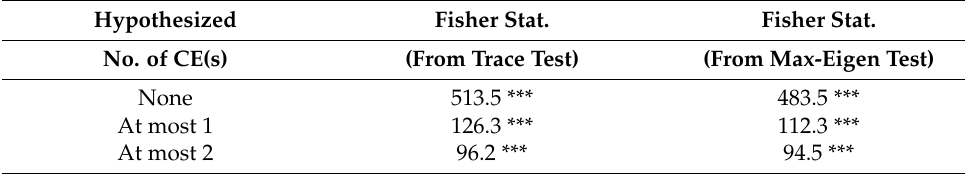
Table 8. Fisher (combined Johansen) test results. Hypothesized Fisher